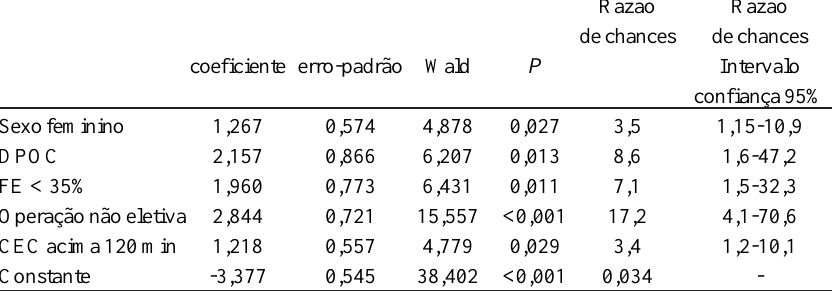
Tabela 7. Fatores de risco pela regressão